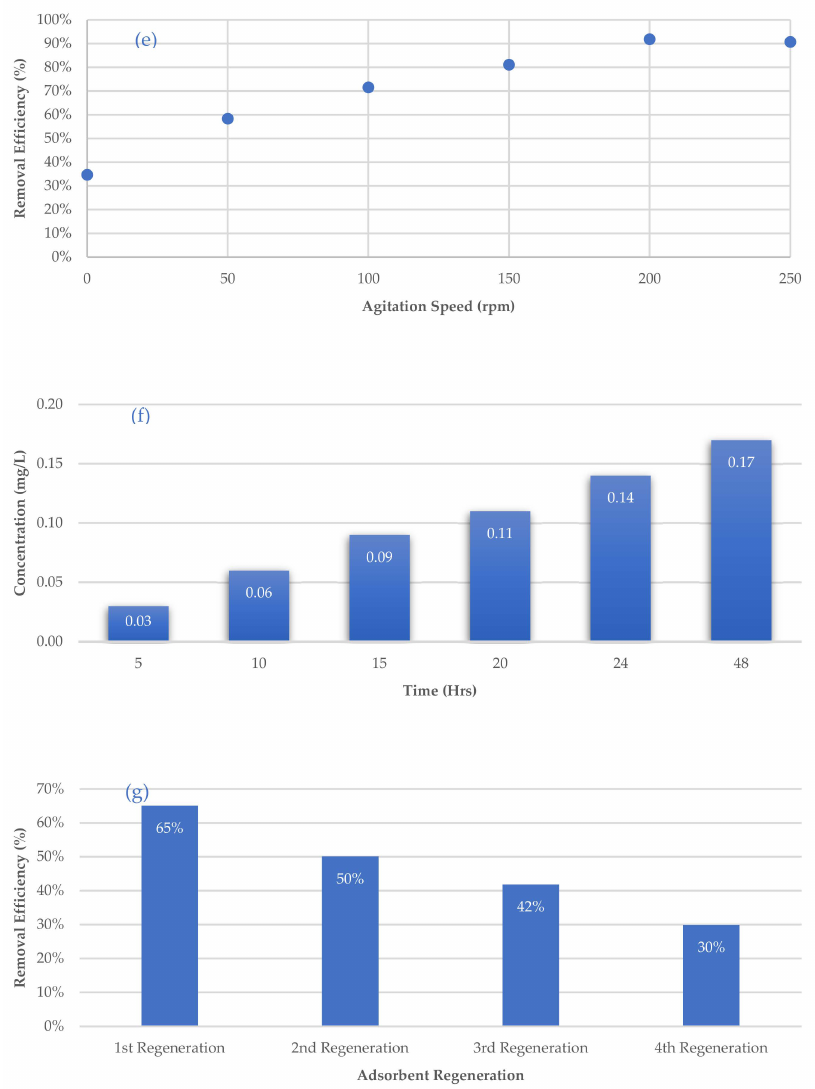
Figure 11. Effects of:( a ) contact time and initial concentration, ( b ) initial pH, ( c ) point zero charge, ( d ) sorbent dosage, ( e ) agitation speed, ( f ) desorption outputs, ( g ) Adsorbent